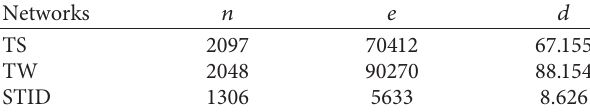
Table 1: General network information of the three networks.